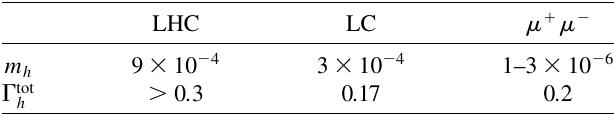
mination of the h 0 (cid:3) (cid:2) (cid:3) (cid:1) coupling is possible. This will provide another strong discriminator between the SM and the MSSM. Further, the h 0 (cid:3) (cid:2) (cid:3) (cid:1) coupling can be compared to the muon collider and LC determinations